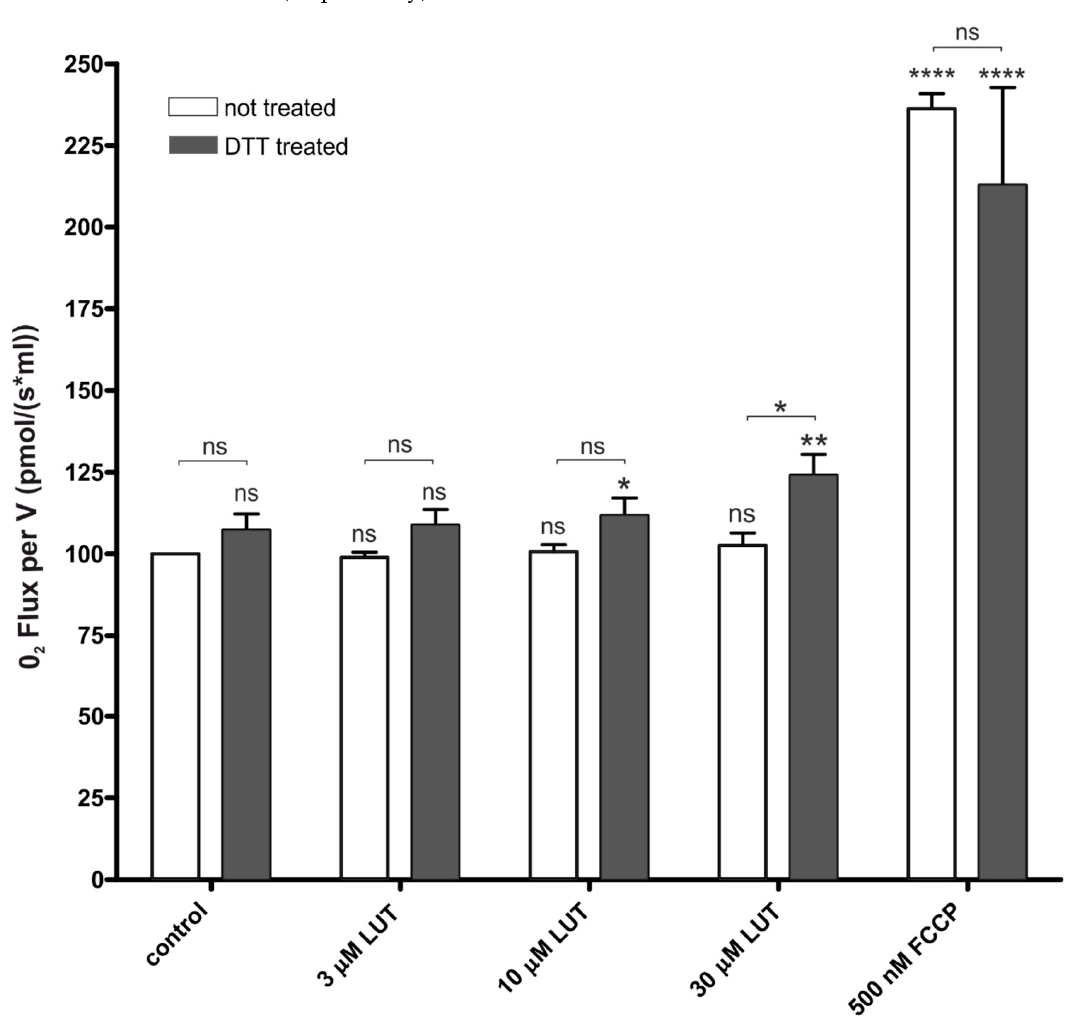
Figure 4. Changes in oxygen consumption in control and DTT-treated endothelial cells under the influence of LUT. A comparison of the data for the effect of 3, 10 and 30 μ M LUT on cell respiration in the control group and those treated with 0.5 mM DTT is presented. Statistical significance levels, with respect to non-treated control (above the column) and between probes, were determined using the two-way ANOVA with Tukey’s test for n = 3 ( p < 0.05 (*), p < 0.01 (**), p <0.0001 (****), p > 0.5 (ns)).